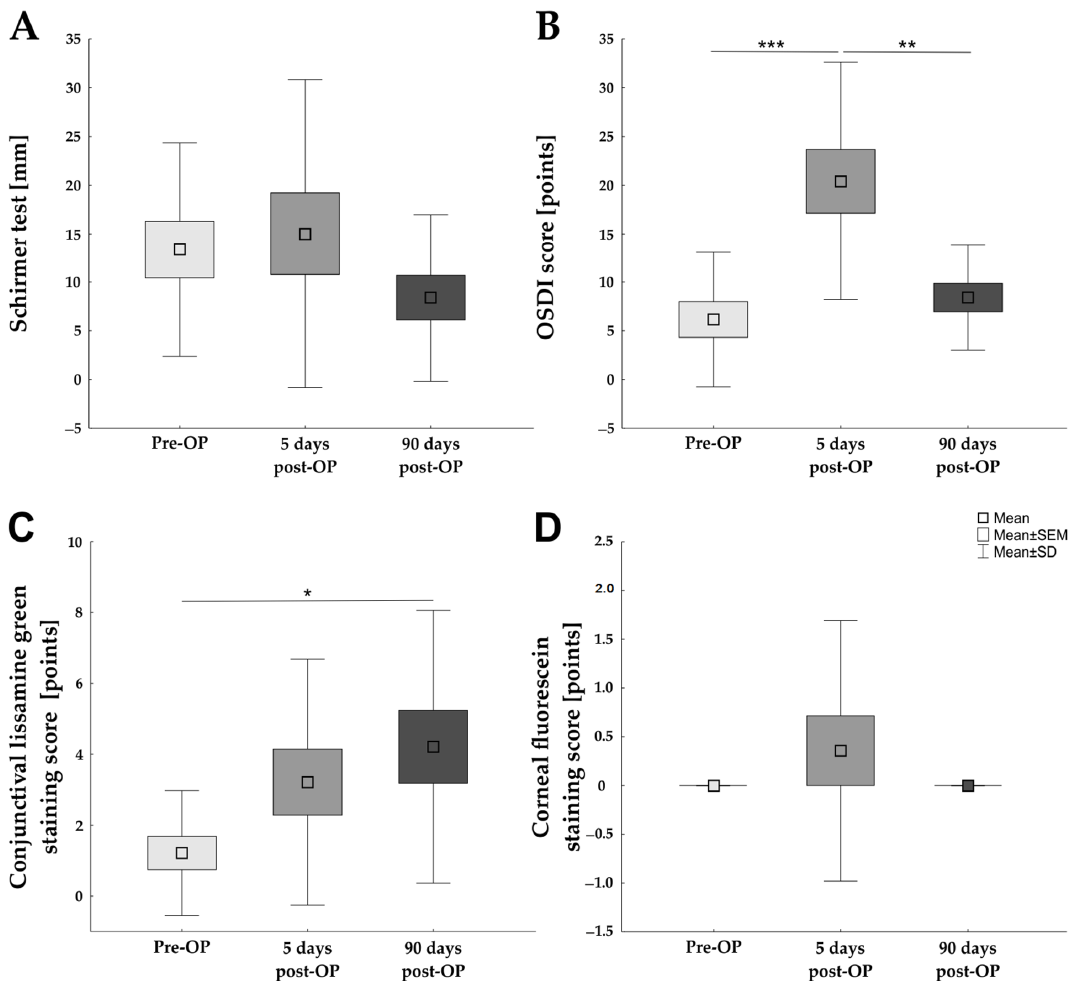
Figure 1. Classic dry eye examinations over time. ( A ) No significant difference in the Schirmer test values was detected between pre-OP, 5 days post-OP, and 90 days post-OP. ( B ) The OSDI score was significantly increased at 5 days post-OP in comparison to pre-OP and 90 days post-OP, respectively. ( C ) The conjunctival lissamine green staining showed an increasing trend postoperatively and was significantly upregulated 90 days post-OP in comparison to the preoperative investigations ( D ) Results of the corneal fluorescein staining score revealed no differences between the three investigation points in time. Values are mean ± SEM ± SD; * p < 0.05; ** p < 0.01; *** p < 0.001. Abbreviation: OSDI = ocular surface disease index.